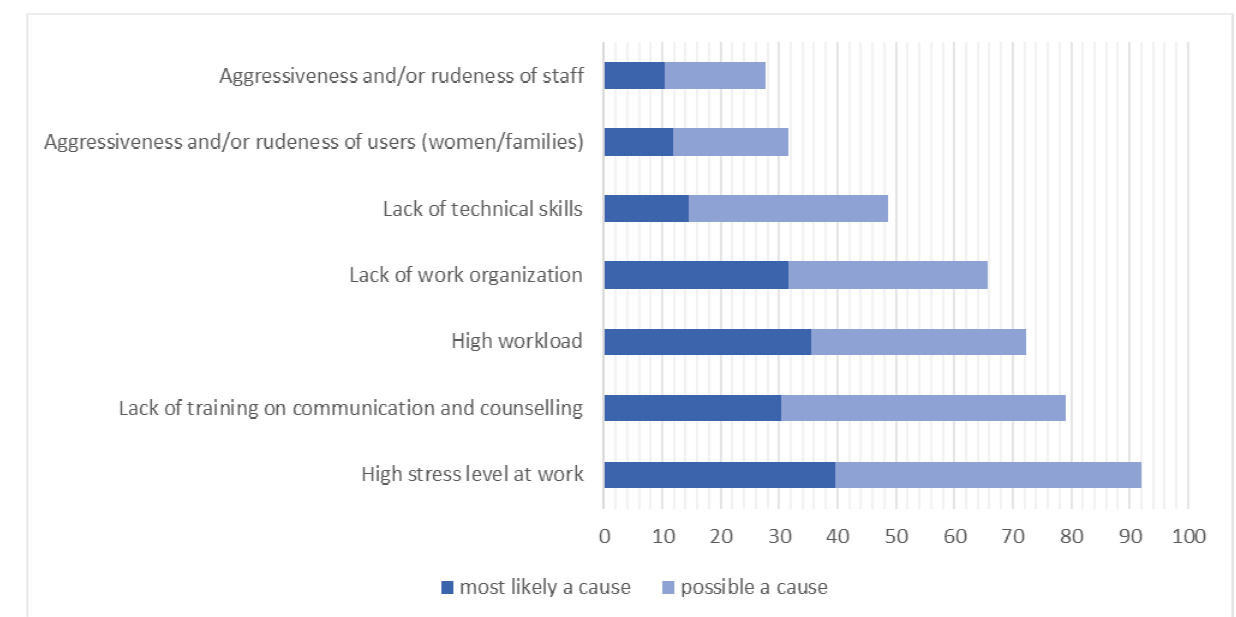
Figure 3. Health workers’ perspectives on causes of ineffective communication with women and families during childbirth (N = 76 *). Notes: * only health staff who judged communication with women/families partially adequate or not adequate answered the following question: “how much do you think that the following factors, may be the causes of ineffective communication with women and their families in your facility?” which had pre-determined answer